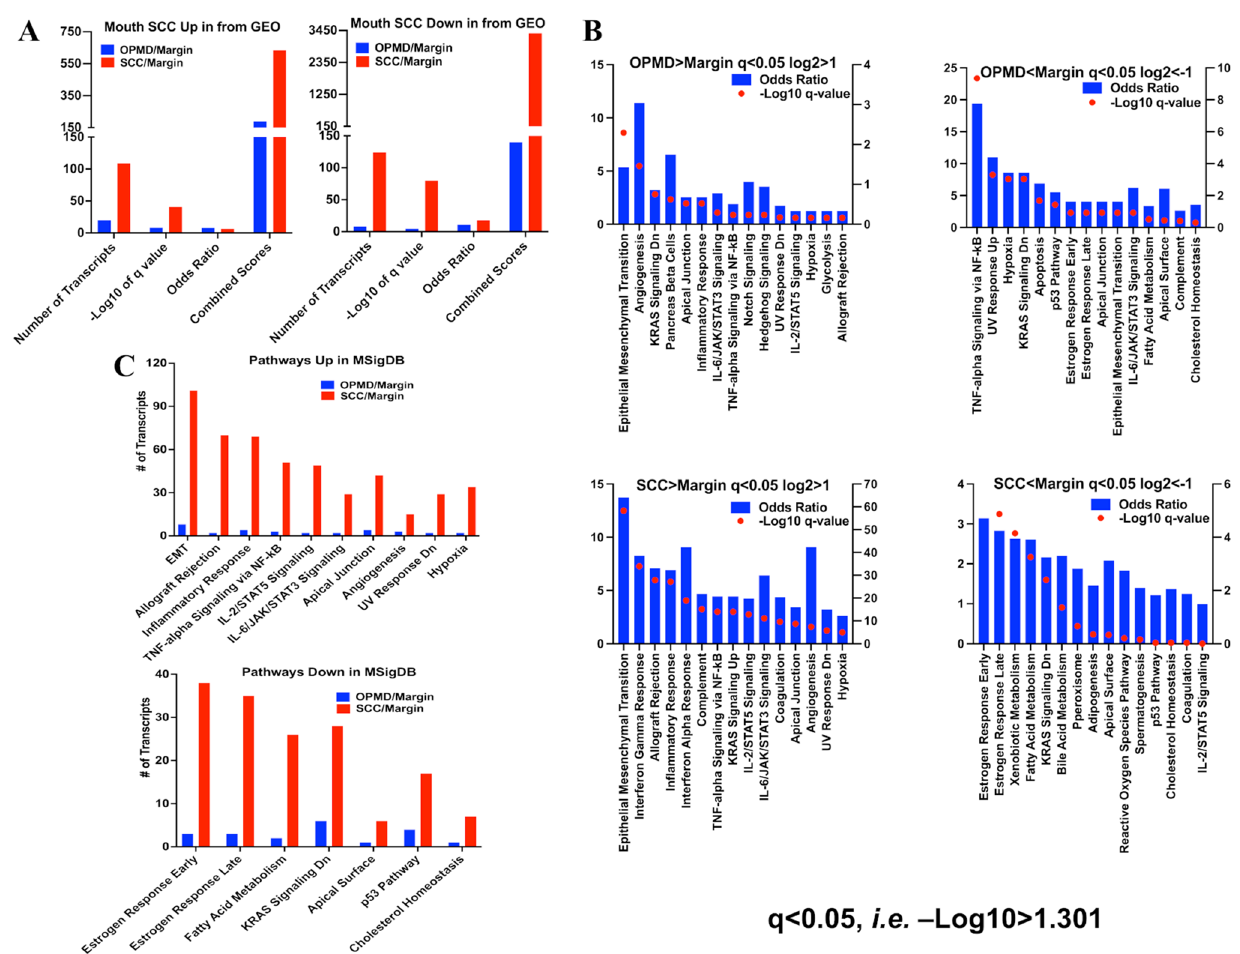
Fig. 2 Pathway analysis transcriptomic changes in human tongue oral potentially malignant disorders (OPMD) and squamous cell carci- noma (SCC). A The association between significantly altered transcripts (q < 0.05, log2 > 1 or < − 1) in OPMD and SCC and human oral SCC using Disease Perturbations from GEO database. B Pathway enrichment analysis of significantly altered transcripts (q < 0.05, log2 > 1 or < − 1) in OPMD and SCC using Molecular Signatures Database (MSigDB). Left Y axis, odds ratio; right Y axis, -Log10 q-value. (C) The numbers of altered transcripts (q < 0.05, log2 > 1 or < − 1) in OPMD and SCC enriched in the top 15 pathways derived from MSigDB